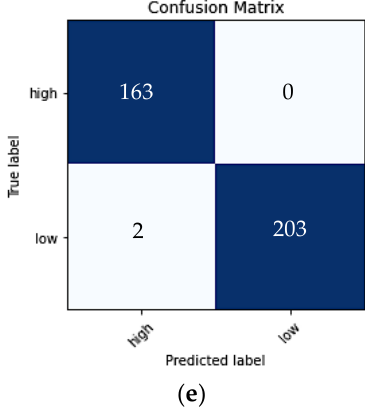
Figure 4. Confusion metrics cross-validation results for ( a ) Model 1 ( b ) Model 2 ( c ) VGG16 ( d ) ResNet50 ( e ) Inception V3.